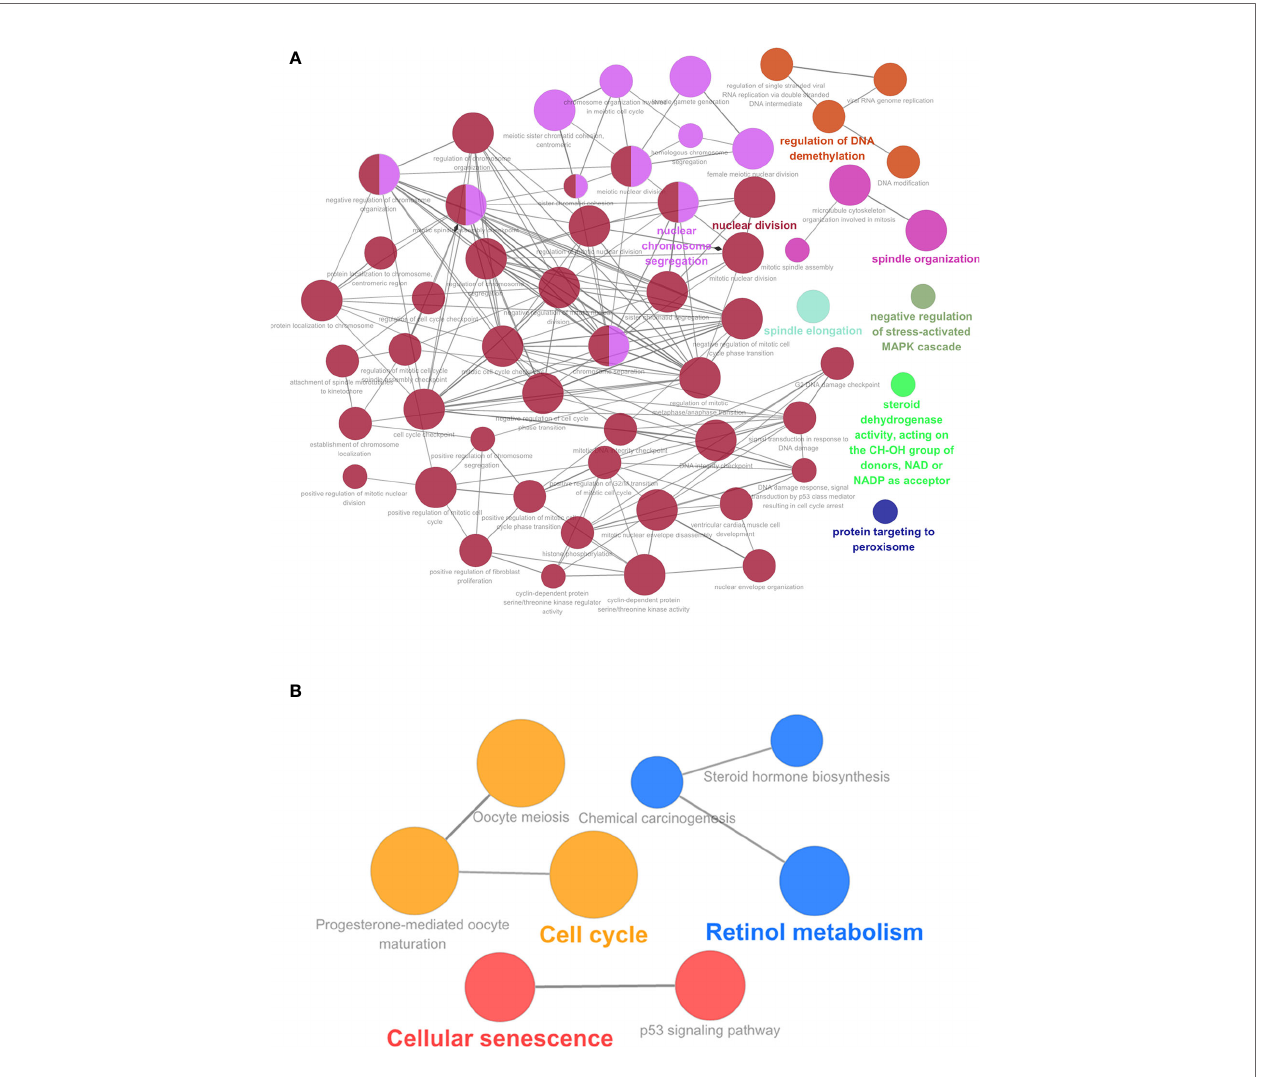
FIGURE 7 | (A) GO analysis of the 114 hub genes. (B) KEGG pathway of the 114 hub genes,